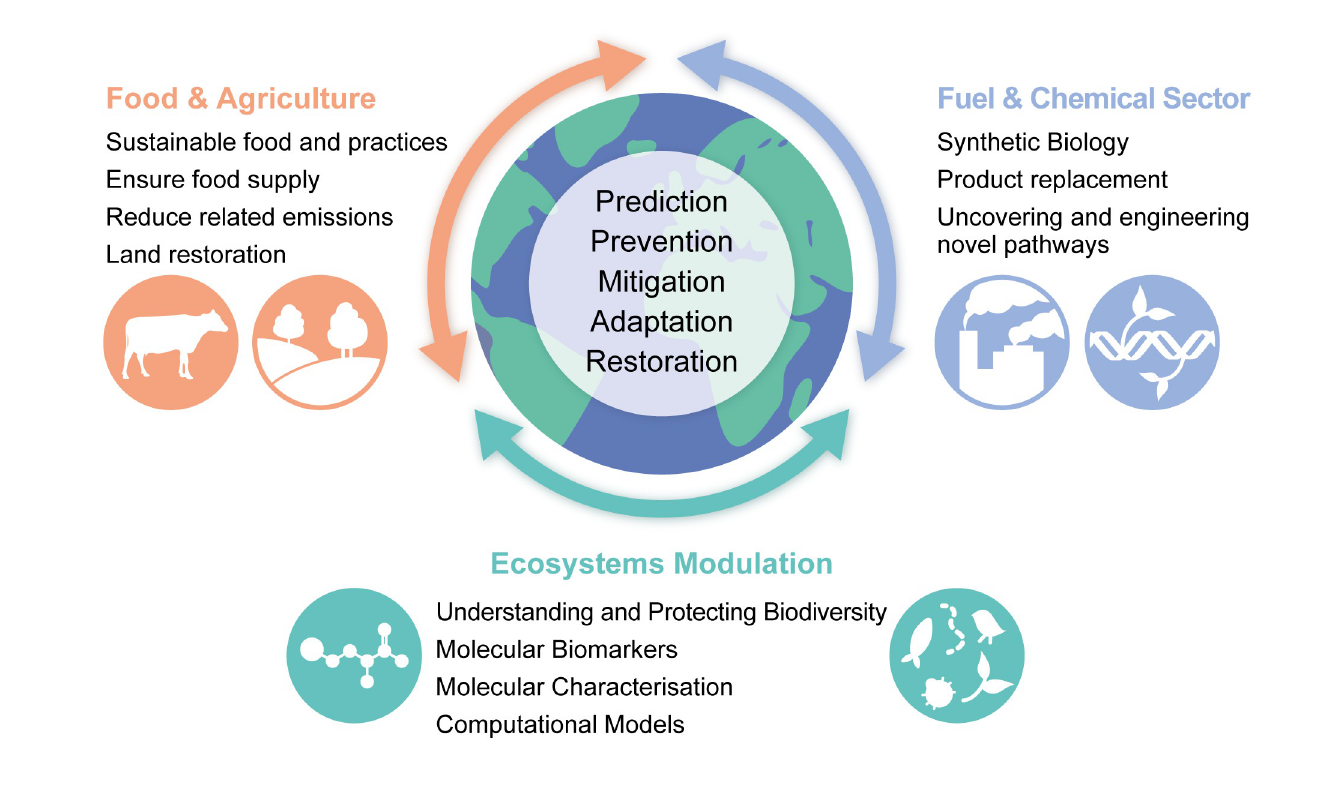
Fig 1. Overview of the main areas wherein molecular biology can make an impact in tackling the current environmental crisis. Molecular biology solutions offer a great potential to tackle the environmental crisis, including that for prediction, prevention, mitigation, adaptation, and restoration. Potential solutions discussed in this Perspective fall under three main categories: Food and agriculture, fuel and chemical sector, and ecosystems modulation. Arrows indicate interconnectivity between the solutions under.